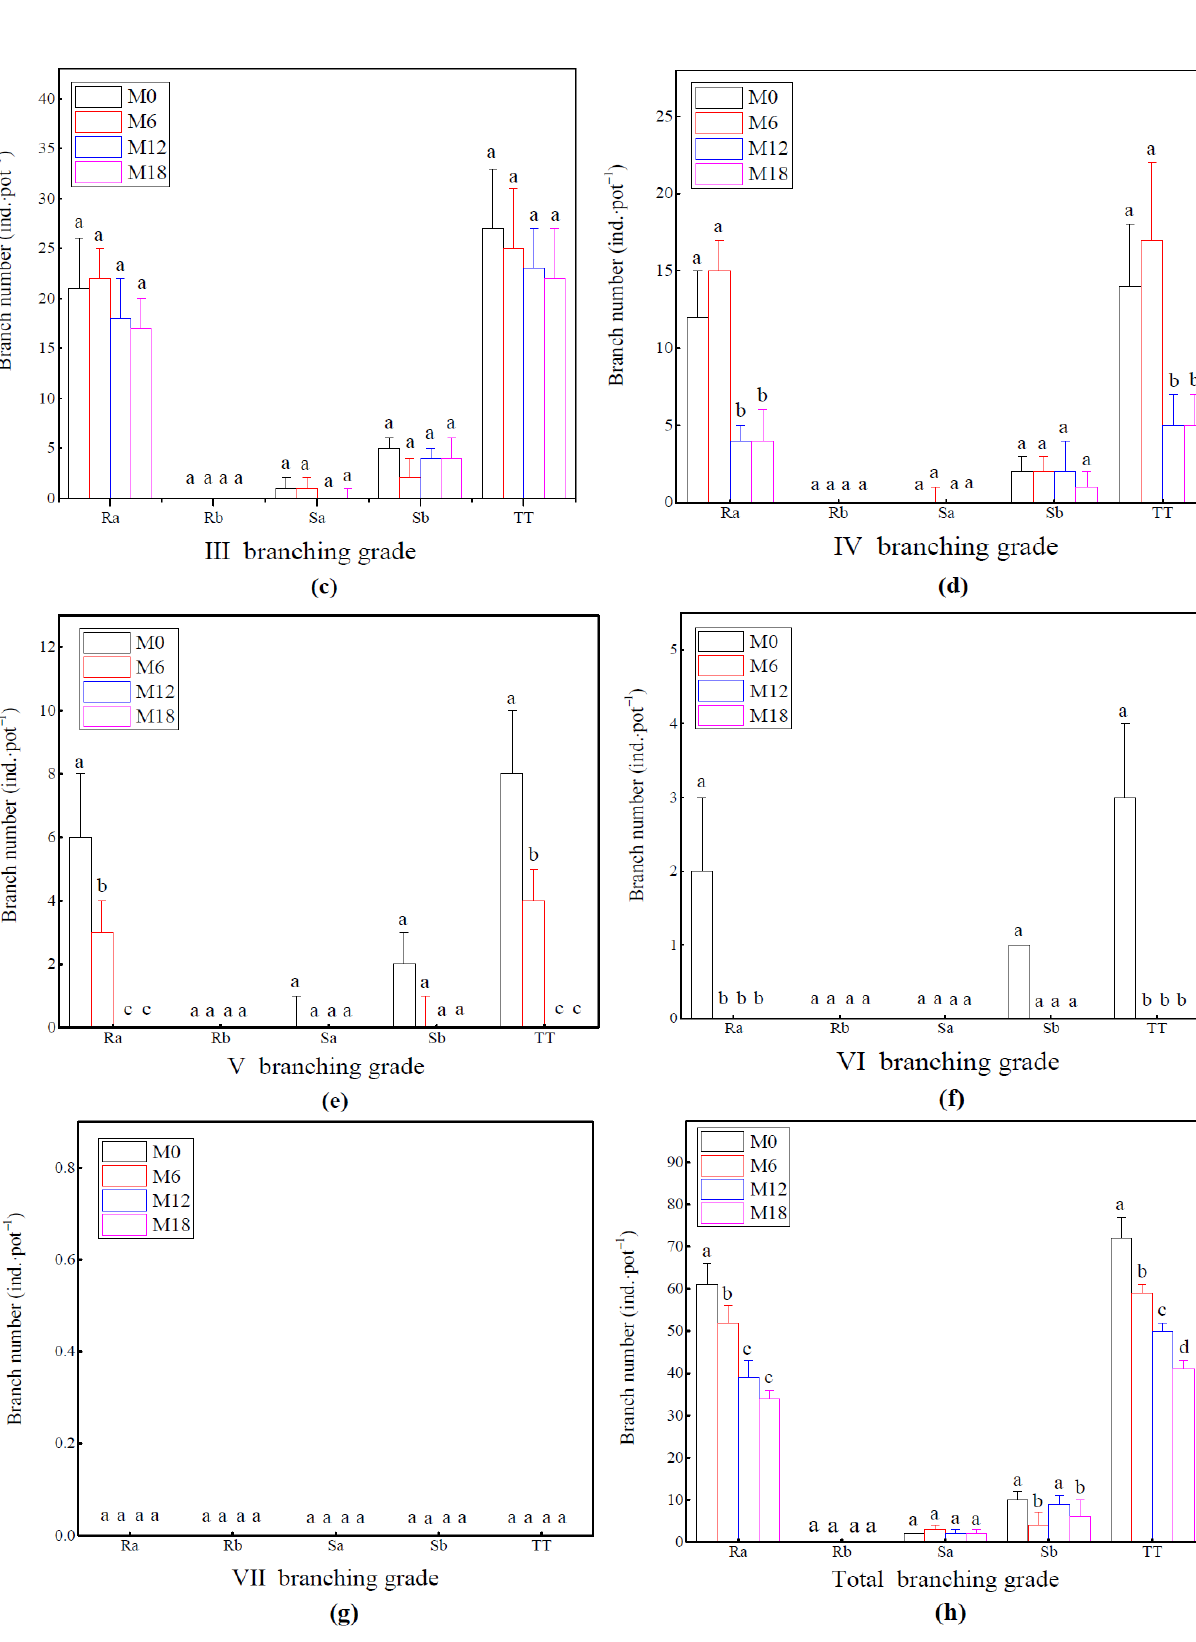
Figure 8. Quantitative characteristics of rhizome branching. ( a ) I branching grade; ( b ) II branching grade; ( c ) III branching grade; ( d ) IV branching grade; ( e ) V branching grade; ( f ) VI branching grade; ( g ) VII branching grade; ( h ) total branching grade. Different letters indicate significant differences ( p < 0.05). Ra: rhizome; Rb: rhizome bud; Sa: bamboo stand; Sb: shoot bud; TT: total type.